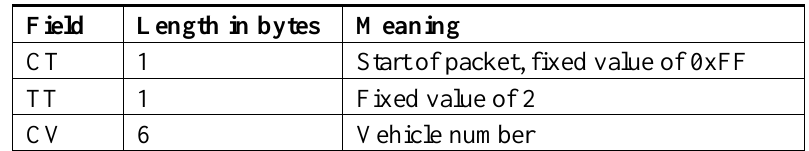
Table 5. Datagram T2.